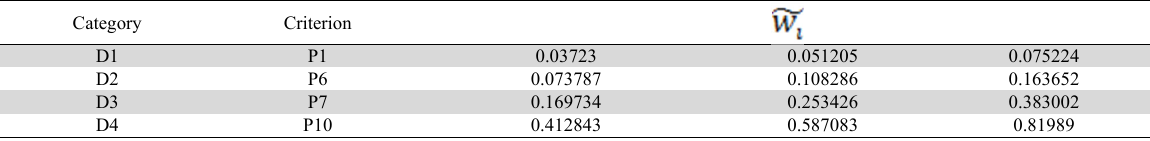
Fuzzy weight distributions Category